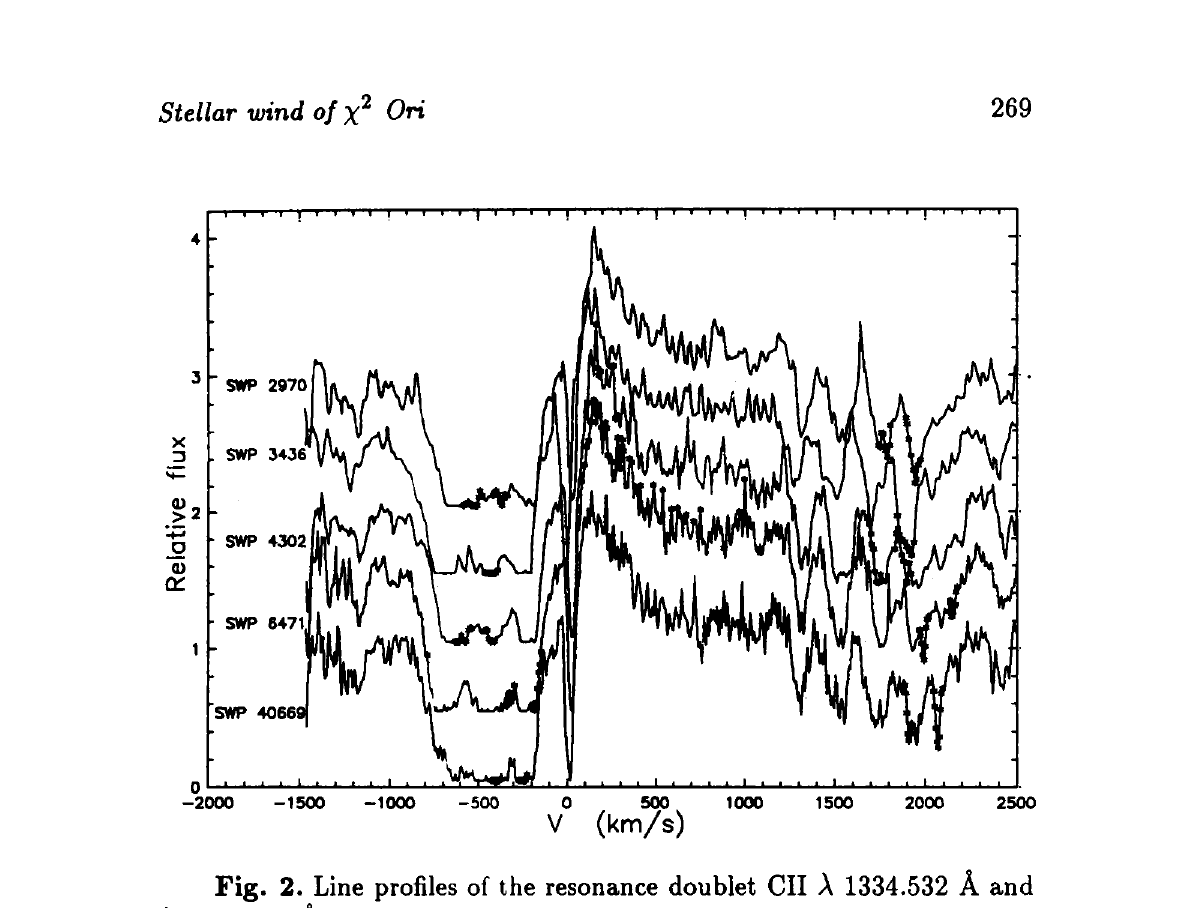
Fig. 2. Line profiles of the resonance doublet CII A 1334.532 Á and A 1335.708 Á. Differently from the AMI and SilV lines, the blue slope of the strongly overlapping doublet components is steeper and the emission component is strong and wide. Both the features exhibit that the zone of the CII resonance line formation lies in higher layers than that of the A1III and SilV resonance